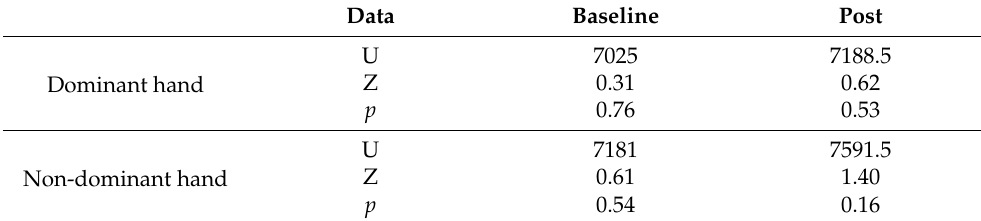
Table 7. Mann-Whitney U-test between male and female BBT scores.